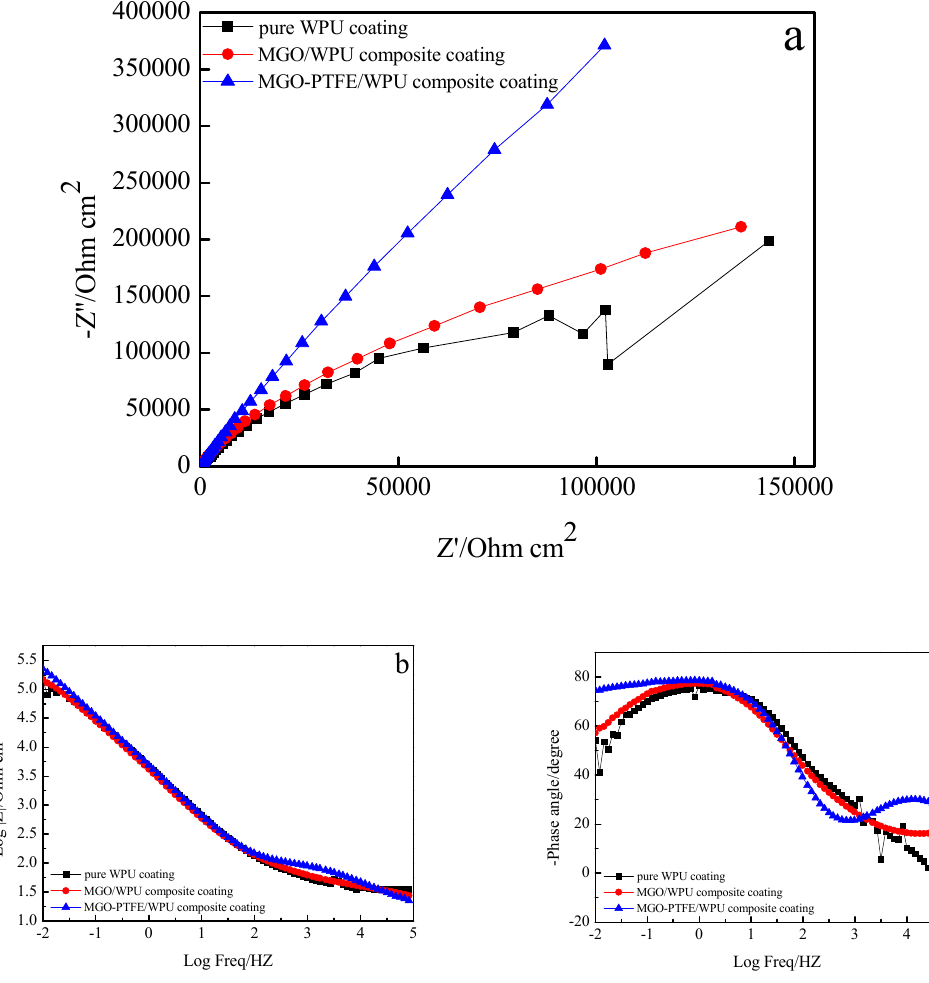
Figure 10. EIS diagrams of pure WPU coating, 1.0 wt.% MGO / WPU composite coating and 1.0 wt.% MGO-PTFE / WPU composite coating after friction, ( a ) Nyquist plot, ( b ) and ( c ) Bode plot.